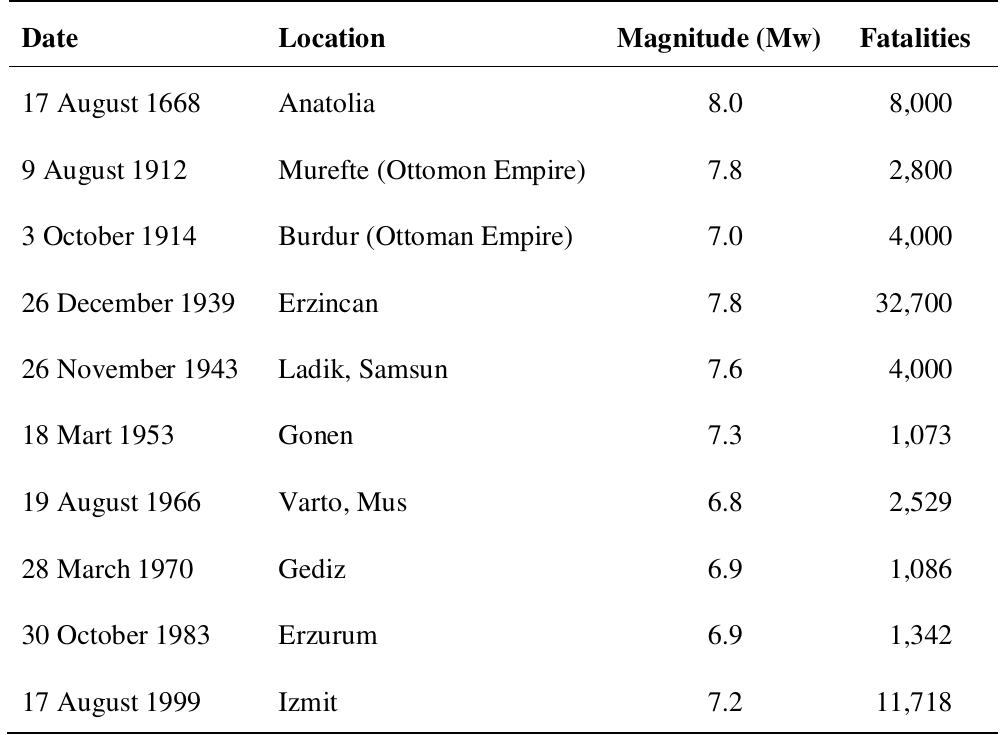
Table 1 . Historical earthquakes in Turkey (USGS,